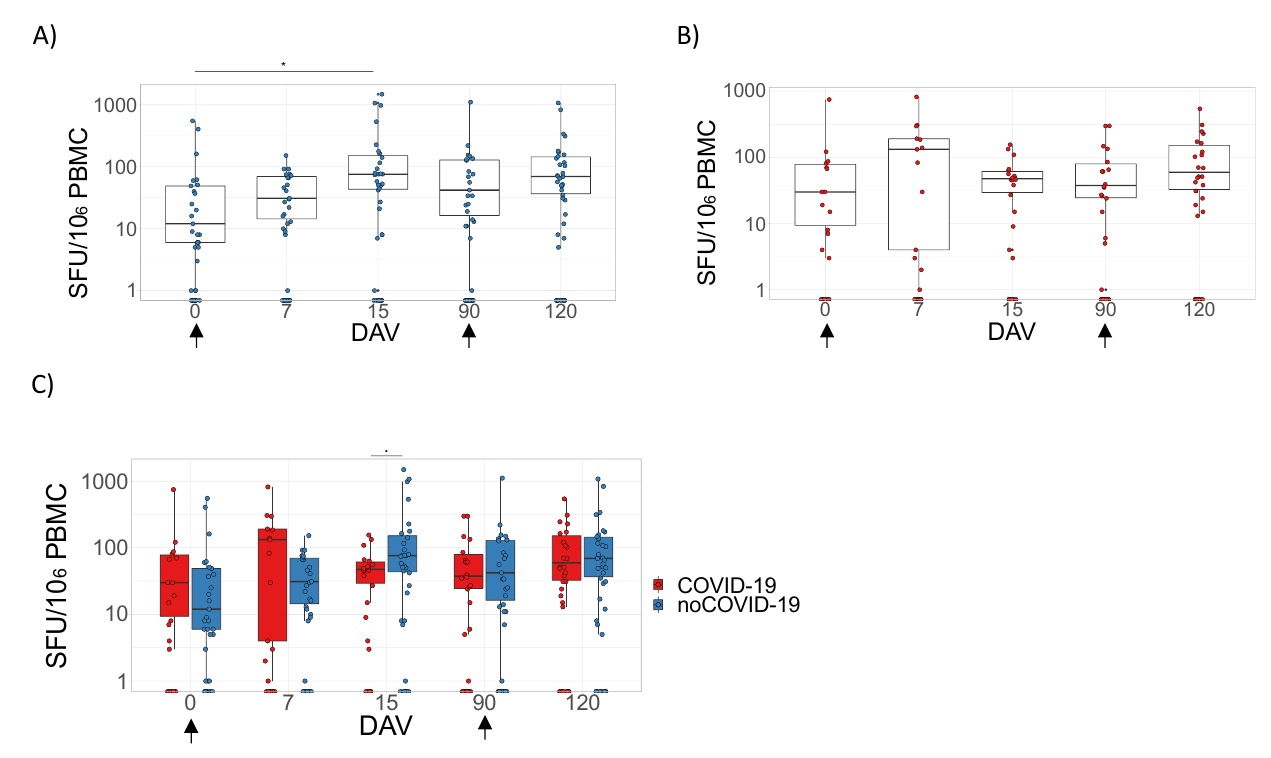
Figure 5. IFN- γ secretion after ChAdOx1 nCoV-19 vaccination. Panels ( A – C ) refer to samples from volunteers immunized with the prime–boost protocol for ChAdOx1 nCoV-19 on days 0 and 90 (indicated by arrows). Data are represented by box plots with the mean and interquartile intervals of IFN- γ spot forming units (SFU). Panels ( A , B ) represent comparisons between time points considering participants without pre-vaccination COVID-19 disease (noCOVID-19) ( A ) or with pre-vaccination COVID-19 (COVID-19) ( B ) using Kruskal–Wallis tests with Dunn’s multiple comparison post-hoc tests. Panel ( C ) represents comparisons between the noCOVID-19 and COVID-19 groups according to the time point analyzed using the Mann–Whitney test. The following levels denoted significance: * p < 0.05. Sample numbers vary according to follow-up segment loss and ELISpot technical exclusion criteria. DAV = days after